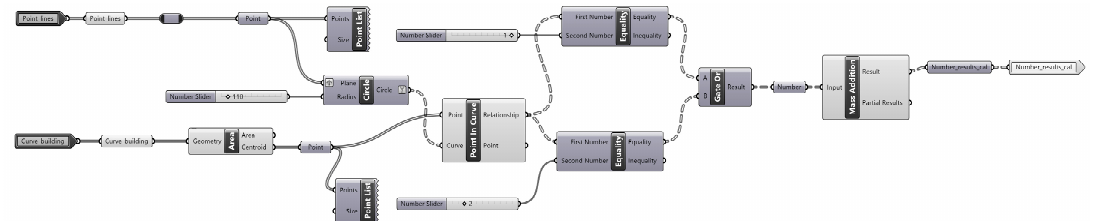
Figure 7. Grasshopper components used to calculate the number of POIs that each axial segment can access within a given radius.